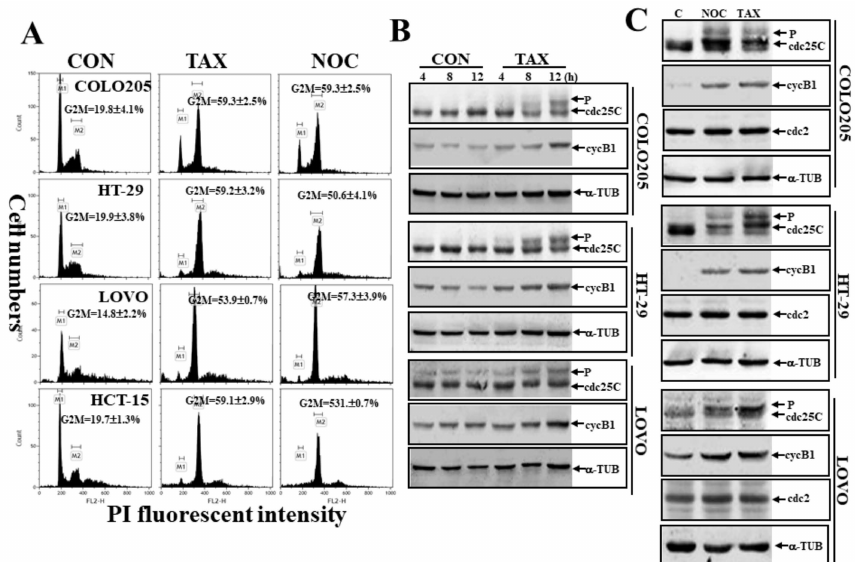
Figure 2. TAX and NOC induced cell cycle arrest at the G 2 / M phase with increased Cdc25C protein phosphorylation and cyclin B1 (cycB1) protein in human CRC cells. ( A ) Induction of the G 2 / M phase by TAX and NOC in human CRC cells. Cells were treated with TAX or NOC (10 µ M) for 24 h, and cell cycle progression of human CRC cells under di ff erent treatments was examined by a flow cytometric analysis using propidium iodide (PI) staining. ( B ) TAX time-dependently induced phosphorylated Cdc25C and cyclin B1 protein expressions in COLO 205, HT-29, and LOVO cells. Cells were treated with TAX (10 µ M) for di ff erent times (4, 8, and 12 h), and expressions of the indicated proteins were examined by Western blotting. ( C ) TAX and NOC induced phosphorylation of Cdc25C and cyclin B1, but not cdc2, in COLO 205, HT-29, and LOVO cells. Cells were treated with TAX or NOC (10 µ M) for 12 h, followed by Western blotting to detect expressions of indicated proteins. Data from three independent experiments were obtained and are displayed as the mean ±